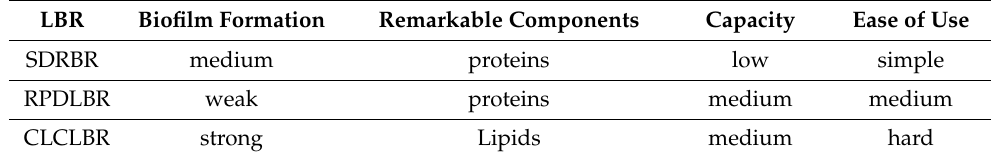
Table 1. The comparisons of characteristics among three kinds of LBRs from the practical viewpoint. LBR Biofilm Formation Remarkable Components